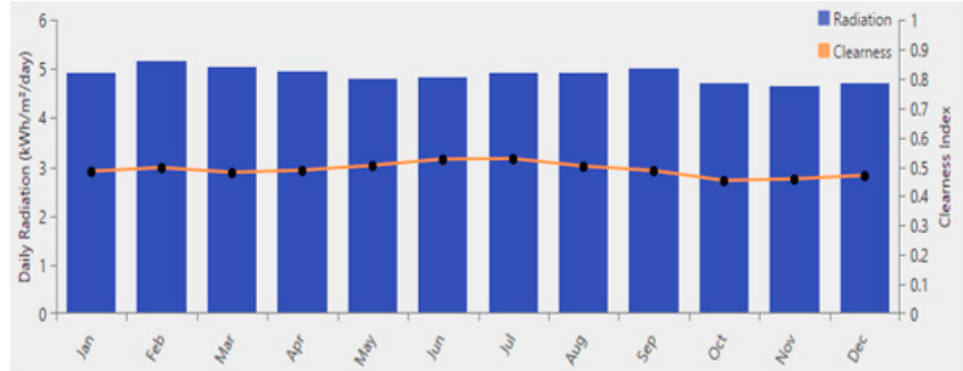
Figure 1. Monthly average solar global irradiance of Kisiizi area.